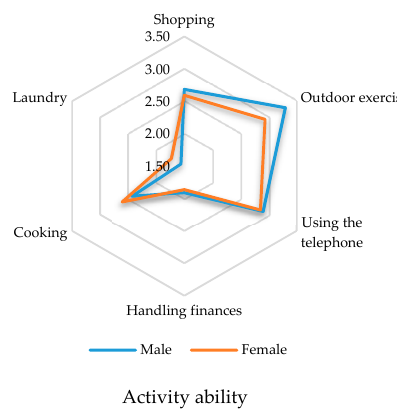
Figure 4. Gender difference of the behavior and health of the elderly population. Figure 4. Gender di ff erence of the behavior and health of the elderly